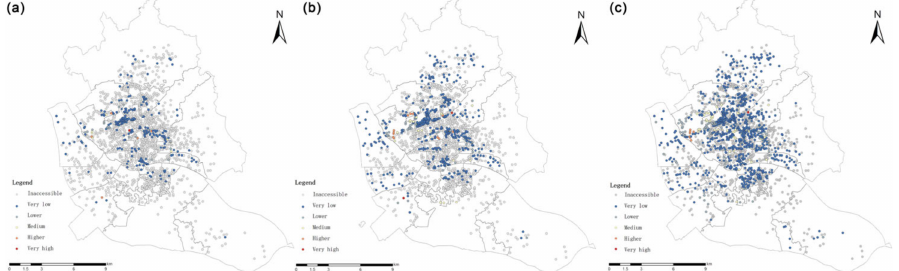
Figure 4. G2SFCA-based residential scale accessibility under different traveling scopes ( a ) 5-min life circle. ( b ) 15-min life circle. ( c ) 30-min life circle.